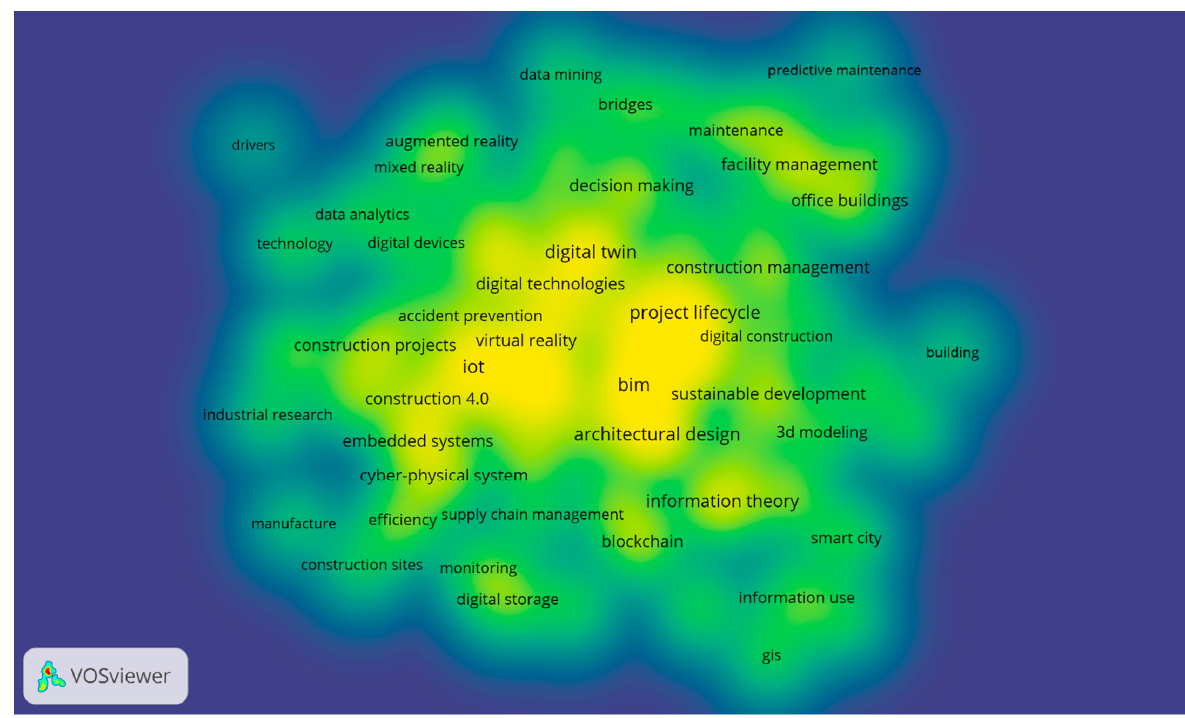
Figure 12. Co-occurrence network map temporal overlay performed with VOSviewer.